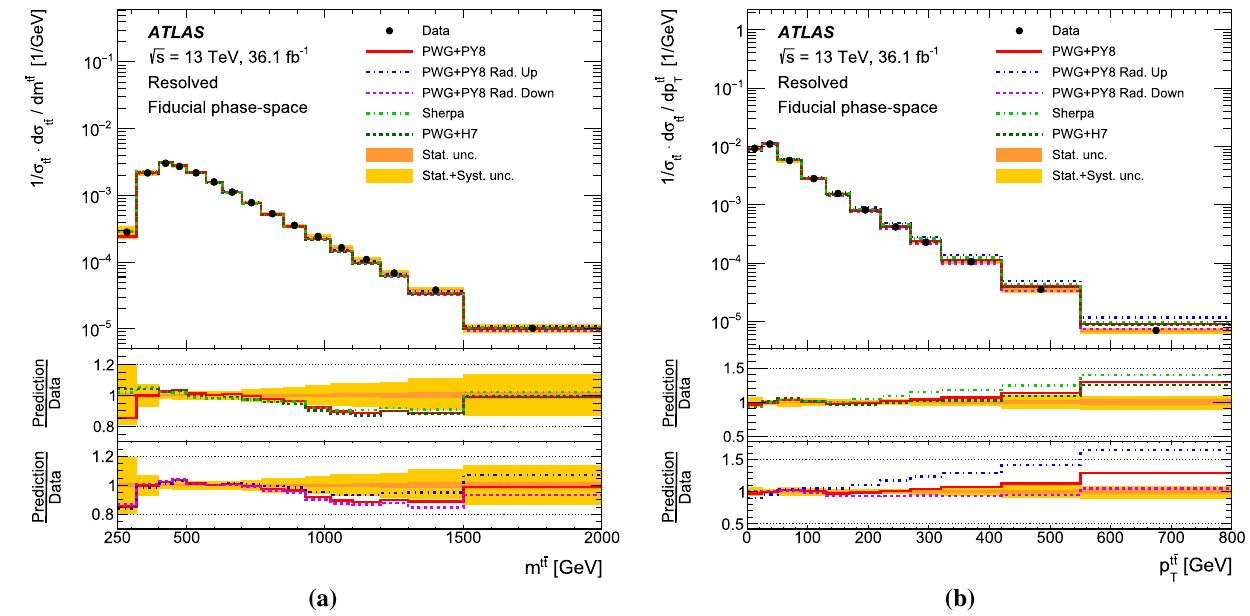
Fig. 24 Particle-level normalised differential cross-sections as a func- tion of a the mass and b the transverse momentum of the t ¯ t system in the resolved topology, compared with different Monte Carlo predic-